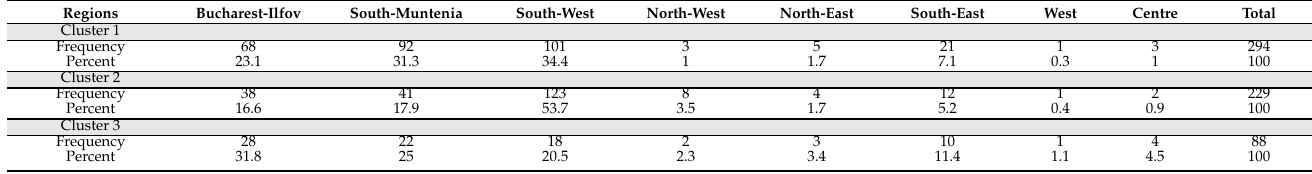
Table 8. Frequency table by clusters and by regions.